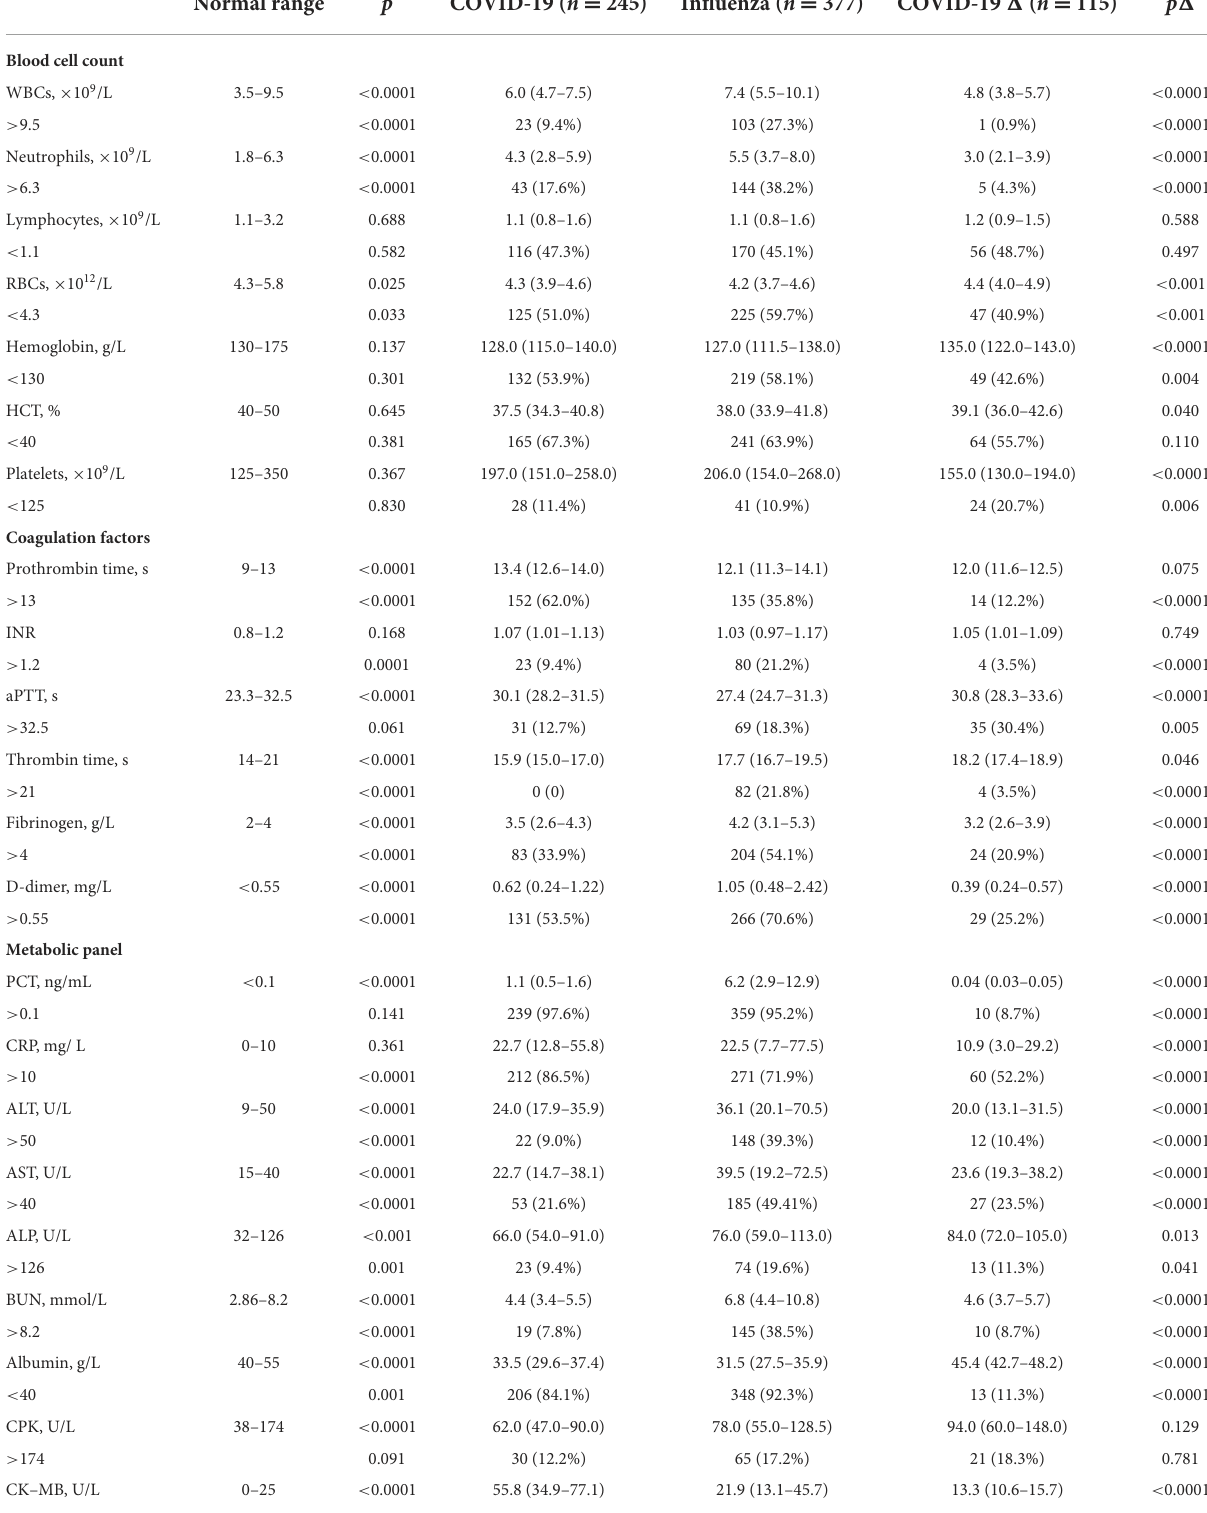
TABLE 2 Laboratory blood tests of the influenza cohort vs. the COVID-19 cohort or COVID-19 1 cohort upon hospital